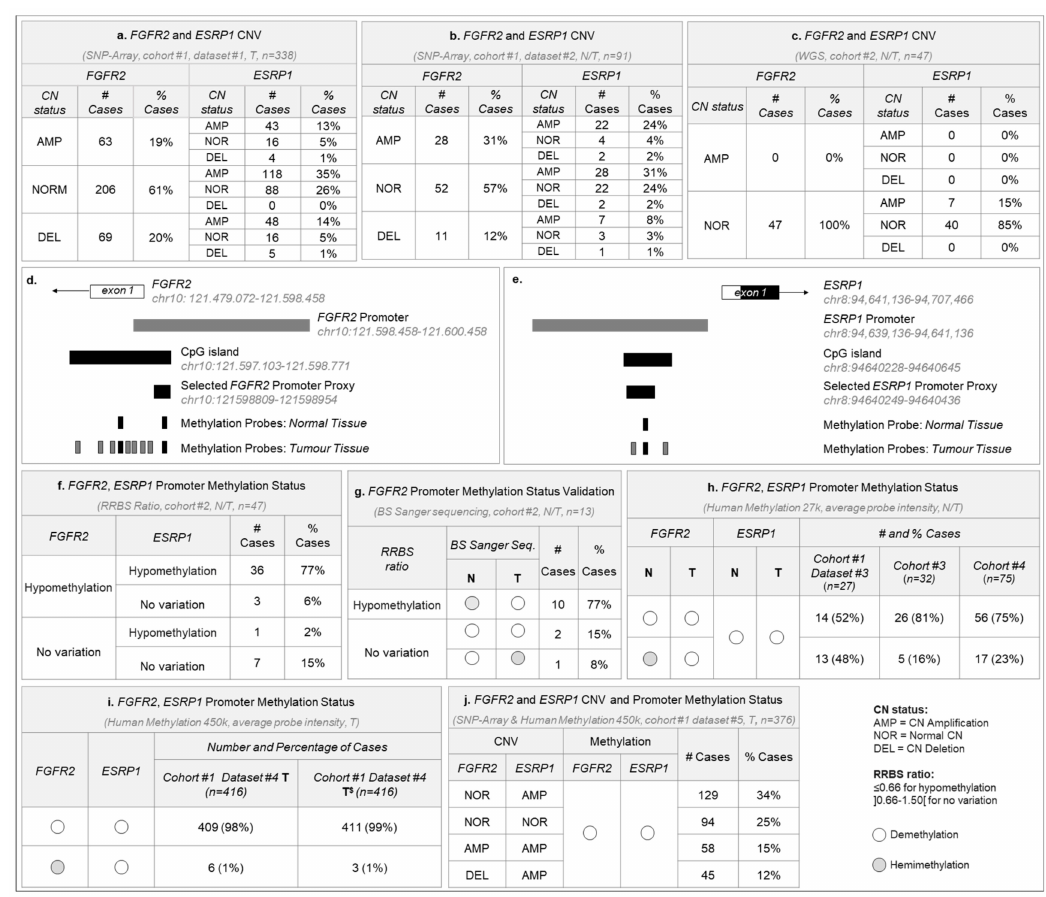
Figure 1. FGFR2 and ESRP1 somatic copy number and promoter methylation status across several gastric cancer cohorts. ( a ) FGFR2 and ESRP1 Copy number status for cohort #1 dataset #1 tumor samples (TCGA, n = 338 GC unpaired samples). Most samples display amplification for at least one of the genes. ( b ) Same as (a) for cohort #1 dataset #2 tumor samples (TCGA, n = 91 normal and GC paired samples). Most samples display amplification for at least one of the genes. ( c ) Same as ( a ) for cohort #2 tumor samples ( n = 47 normal and GC paired samples). Most samples present normal copy number for both genes. ( d ) Representation of the 5’ region of the FGFR2 human locus , the promoter analyzed by Reduced Representation Bisulfite Sequencing (RRBS) in cohort #1, the predicted CpG island, the region selected for Bisulfite Sanger Sequencing validation (proxy) and the analyzed 9 methylation probes available in normal mucosa and tumor tissue from collected TCGA and GEO datasets. Black probes are those for which information is available for both normal and tumor tissue. ( e ) Representation of the 5’ region of the ESRP1 human locus , the promoter analyzed by RRBS, the predicted CpG island, the region selected as proxy and the analyzed methylation probes available in normal mucosa and tumor tissue from TCGA and GSE datasets. The black probe is the only for which information is available for both normal and tumor tissue. ( f ) FGFR2 and ESRP1 promoter methylation status according to the RRBS results for cohort #2. Represented is the ratio: number of CpG sites methylated in the tumor sample divided by the number of CpG sites methylated in the paired normal sample. GC cases with ratios equal or below 0.66 are considered hypomethylated while GC cases with ratios between 0.66 and 1.5 are considered without any variation. No GC cases with ratios above 1.5 (hypermethylated) were identified. ( g ) Results of the Bisulfite Sanger sequencing validation of 13 GC cases selected from within cohort #2. Grey circles correspond to hemimethylated samples while white circles correspond to demethylated samples, determined by the analysis of the corresponding electropherograms. Also represented are the observed RRBS ratios. ( h ) Beta-values calculated for the only probe with data available for cases with paired normal and tumor samples from cohort #1, dataset #3 (TCGA, n = 27 cases), cohort #3 (GSE25869, n = 32 cases) and cohort #4 (GSE30601, n = 75